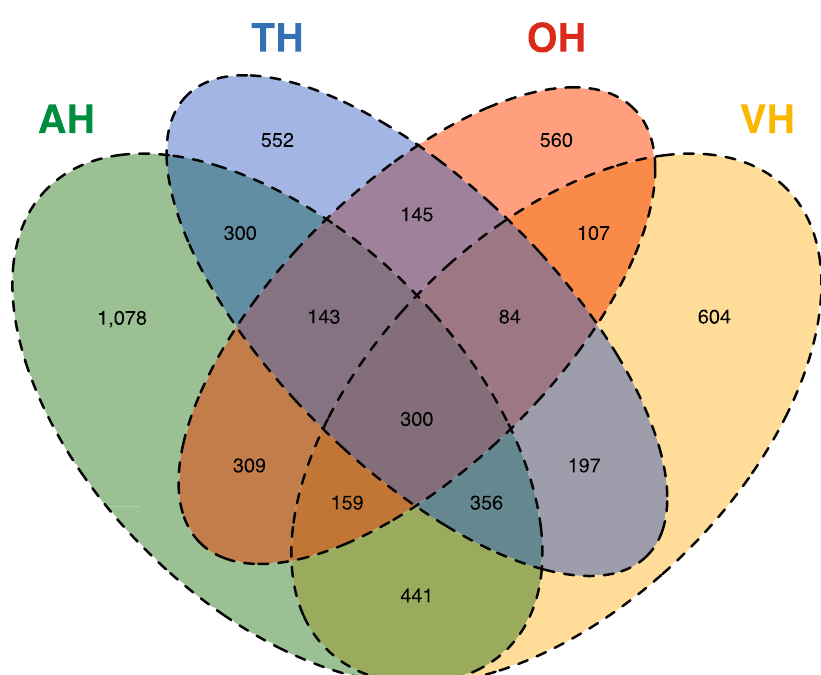
Fig. 5 Overlap between four sensory modalities of hallucinations experienced during the past month. Total n = 5335. Each colored area represents the sample of participants with hallucinations in the past month in the following sensory modalities: auditory (AH; green), visual (VH; yellow), tactile (TH; blue), and olfactory (OH; red). Overlapping areas indicate participants that experience phenomena in overlapping modalities, the accompanying number of participants indicated within that area. Area sizes are not scaled to proportion.